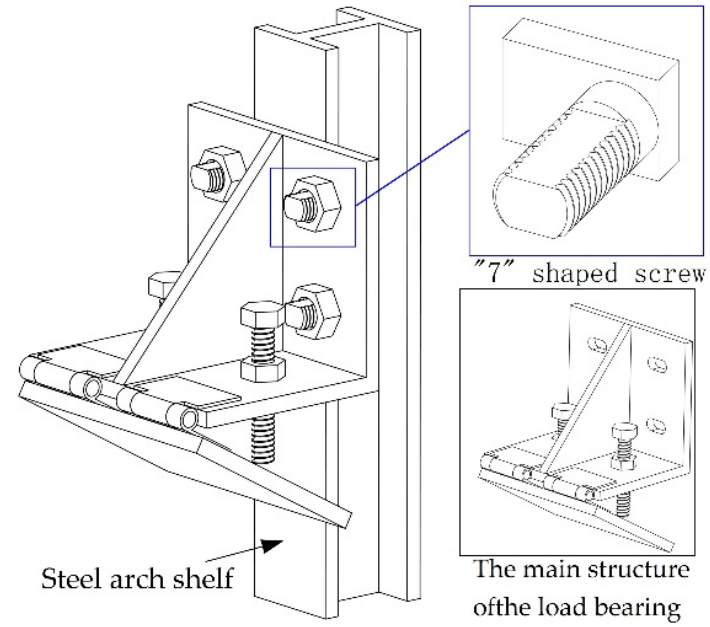
Figure 19. Detail drawing of loading device.